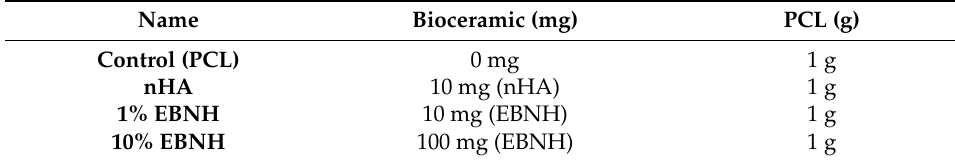
Table 1. Composition of experimental groups and